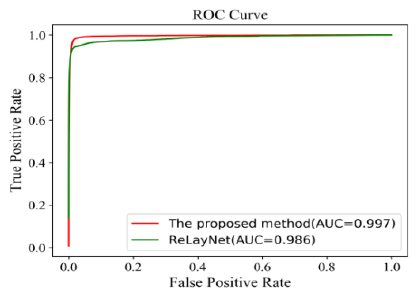
Figure 12. Comparison of ROC curves.